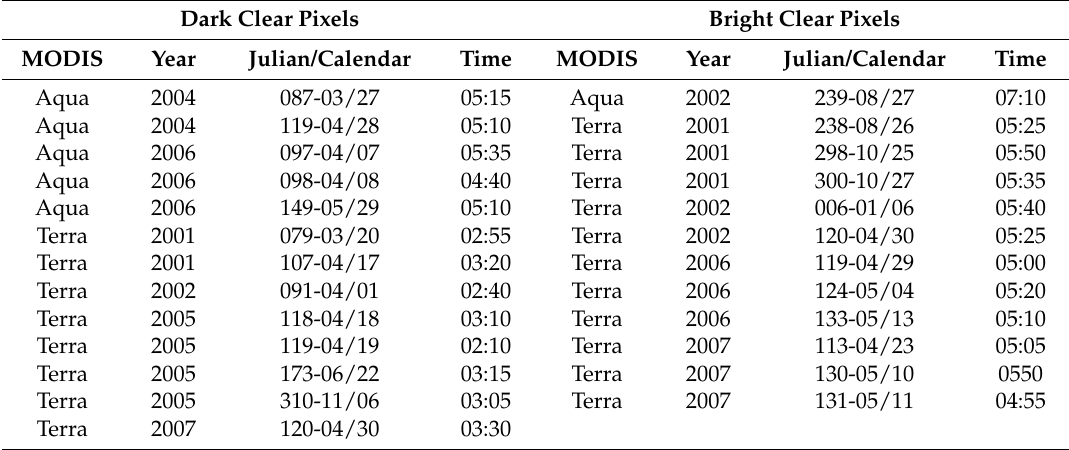
Table 4. Clear scenes selected as training data for spectral and statistical